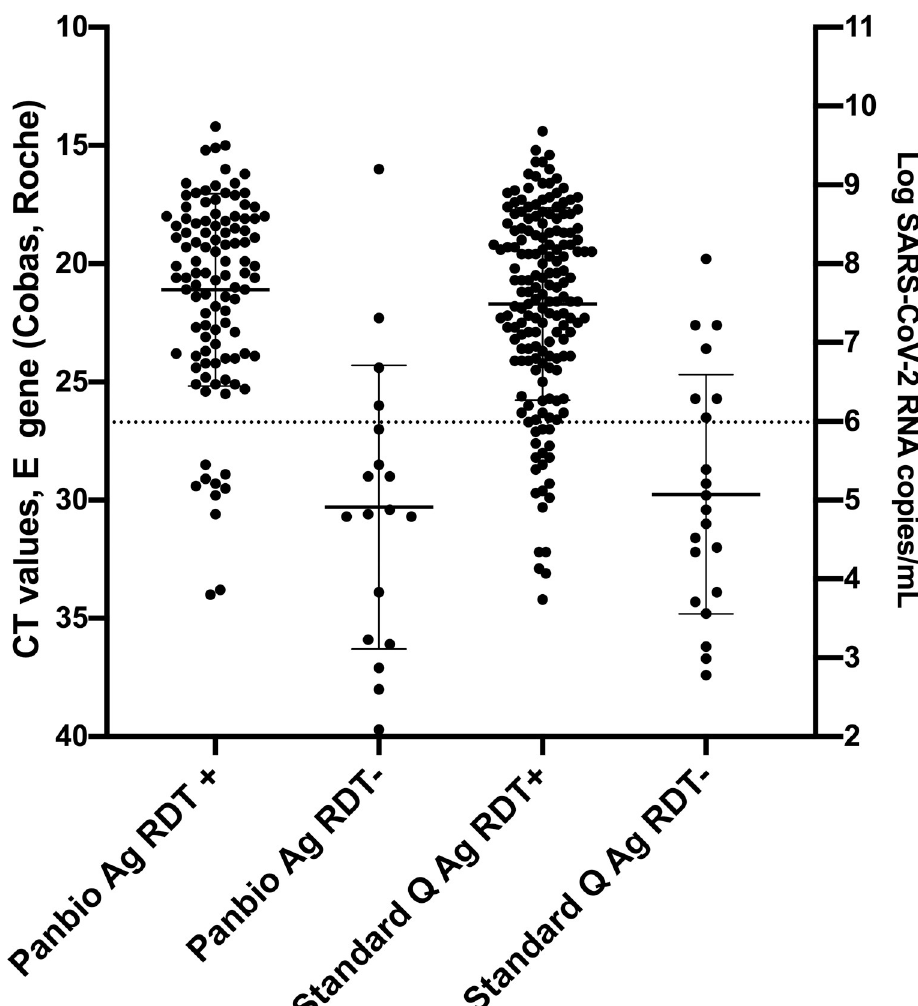
Fig 1. Ct values, viral load and Ag-RDT results for RT-PCR-positive individuals tested with Standard Q (n = 191) and Panbio (n = 124). Horizontal bars represent median and standard deviation. Dotted line: Ct value of 26.7 or 1E6 SARS-CoV-2 RNA copy